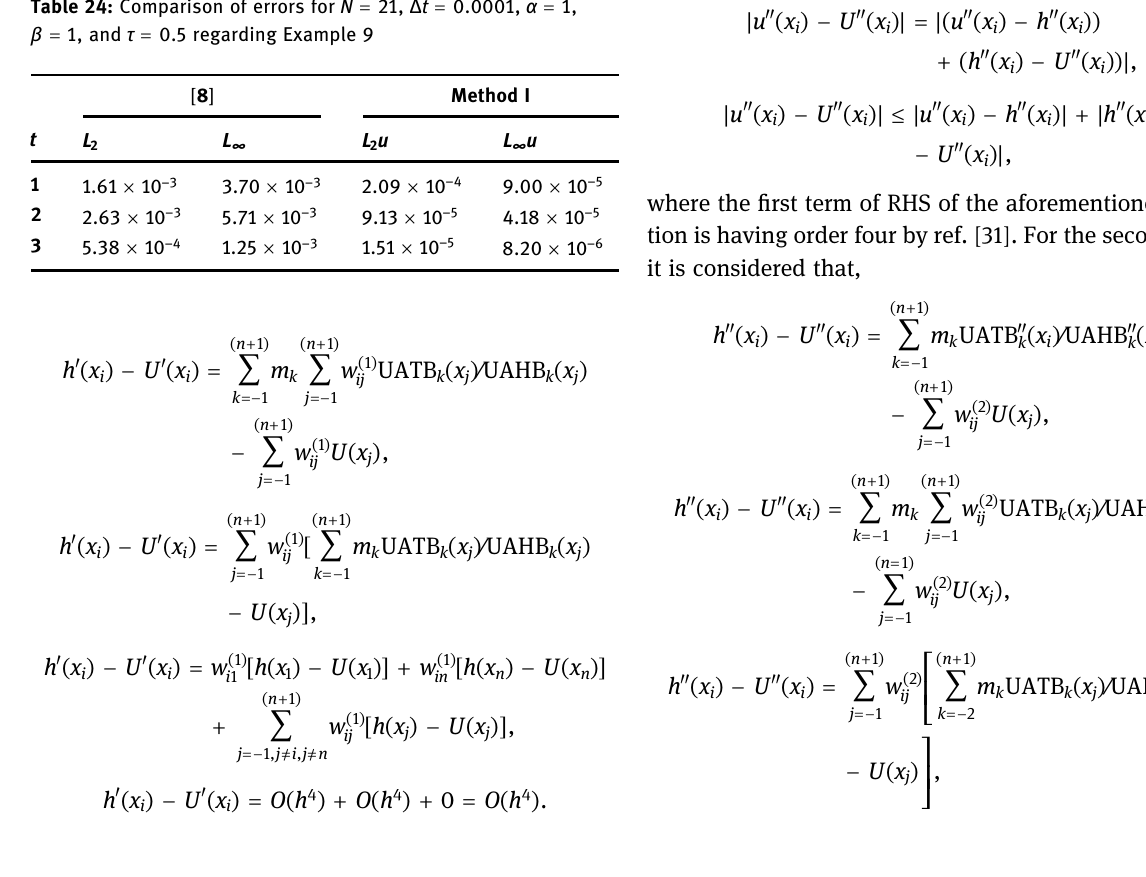
Table 24: Comparison of errors for = N 21 , 0.0001 , = α 1 ,